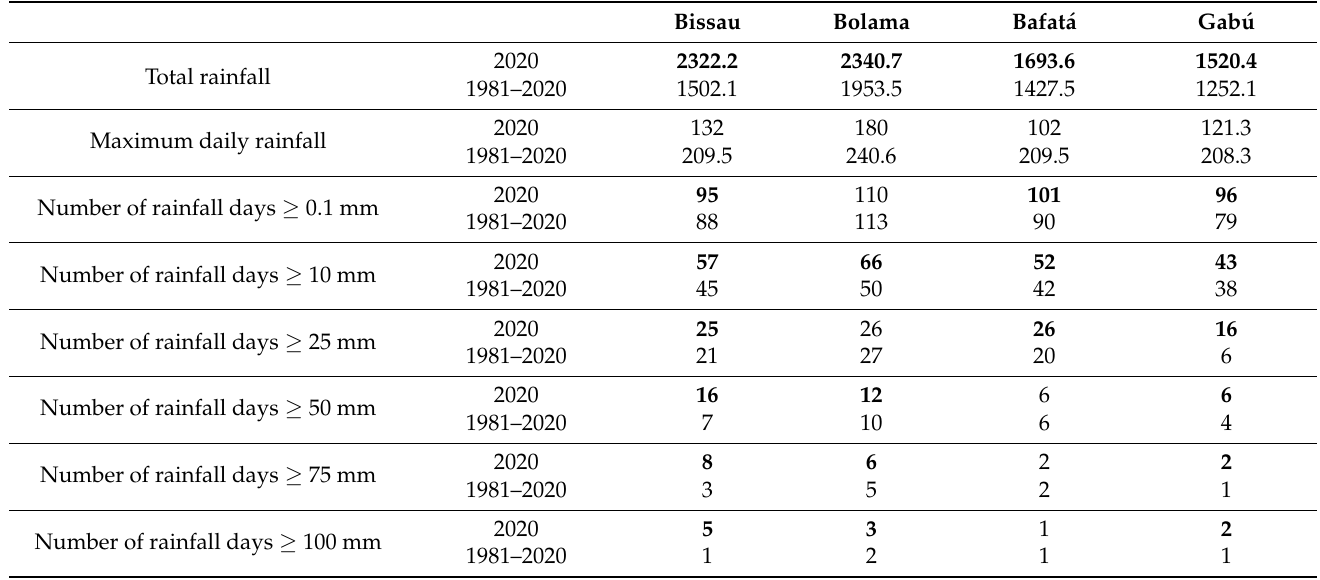
Table 1. Comparison of several rainfall parameters with the corresponding average of the climatolog- ical period (1981-2020) in Guinea-Bissau. Above normal values are indicated in bold. Bissau Bolama Bafat